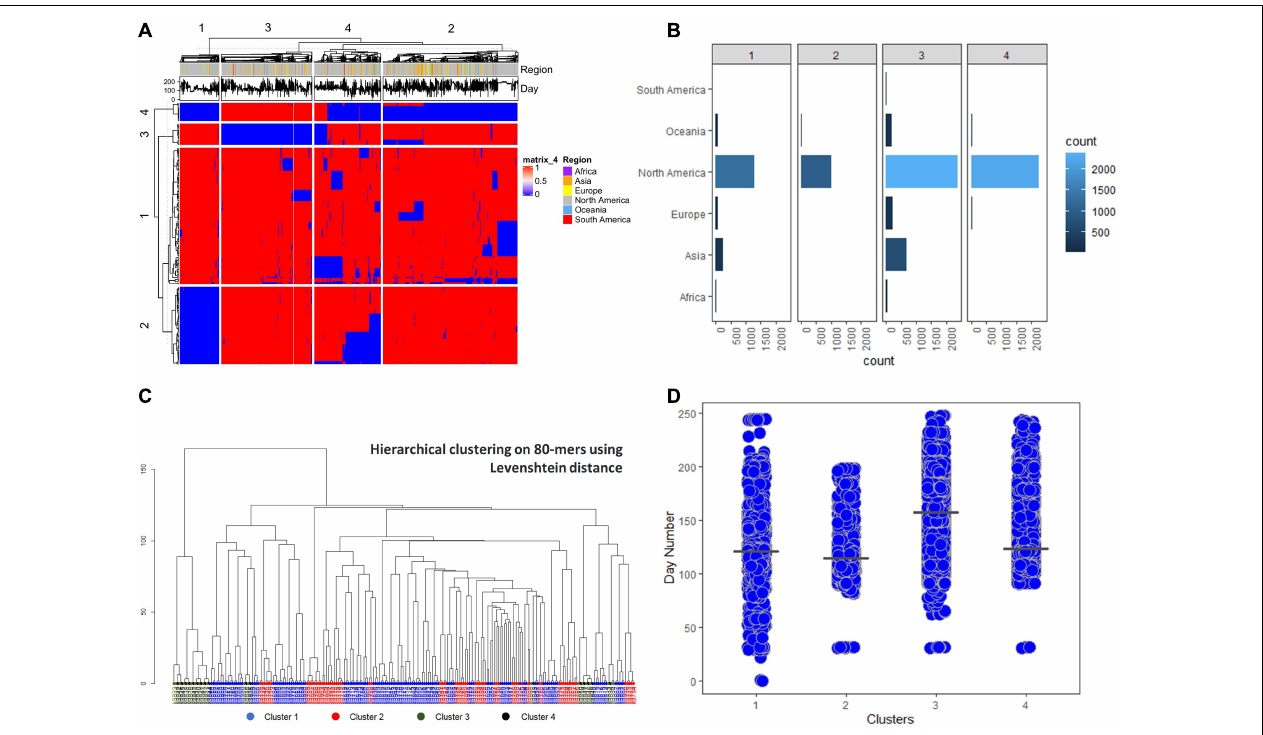
FIGURE 4 | Hierarchical clustering analysis of the 236 selected sequences features (A) The generated heatmap for k ∈ [4 , 80] (B) Number of sequences for every region in the sequence clusters. (C) Hierarchical clustering of the 236 80-mers based on Levenshtein distance. (D) Day count of the sequences in relation to the obtained clusters, considering December 1, 2019 as day 0.